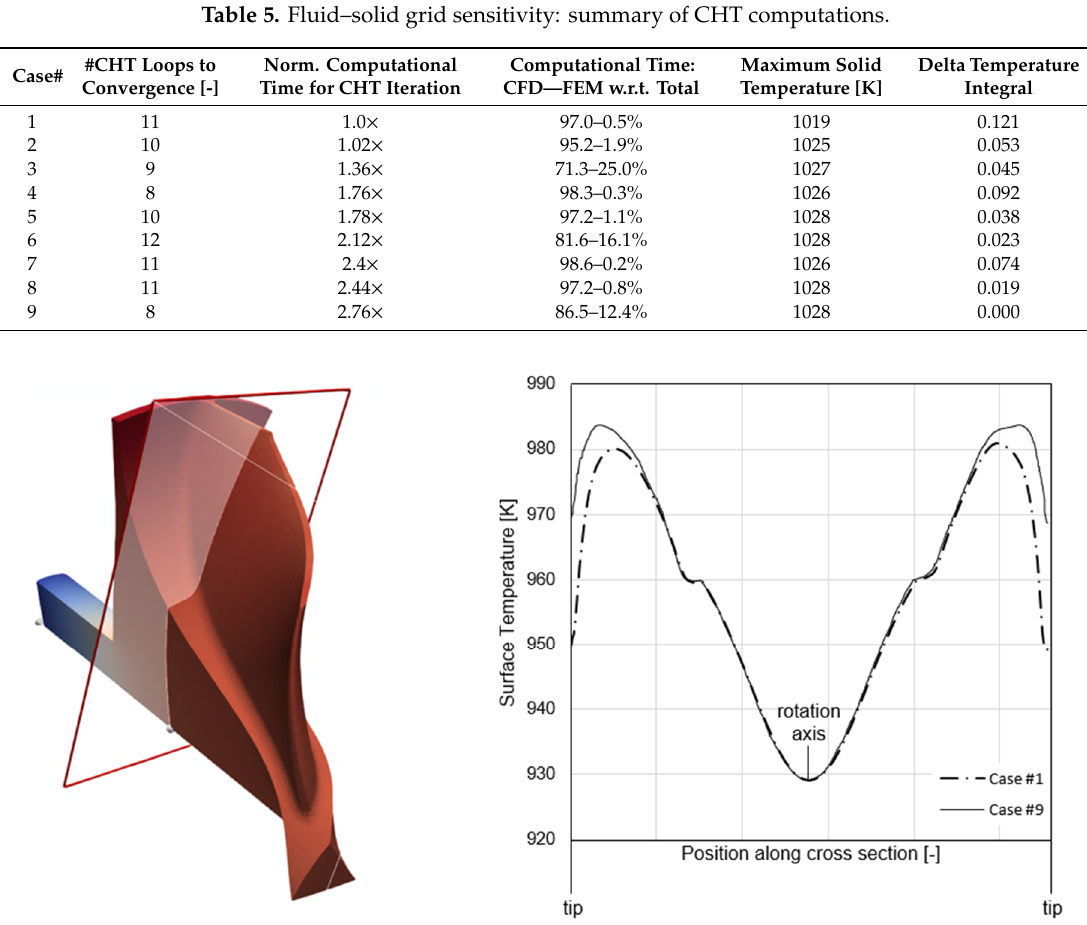
Figure 12. Temperature contours for test case 1 and test case 9 at the planar cross section on the blade.